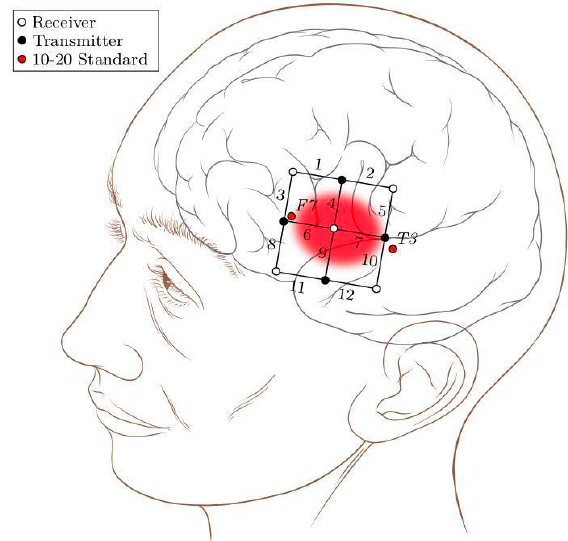
Figure 1. A 12-channel square patch with an inter-optode distance of 3 cm was placed with T3 on one end and F7 on the other. An estimation of the underlying anatomical structures is also shown with Broca’s area highlighted. The head diagram is available at